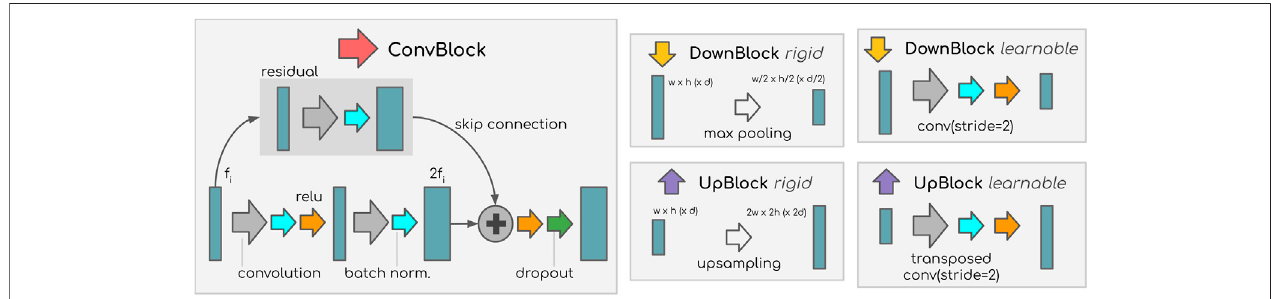
FIGURE 2 | Examples of Modular U-Net blocks. Left: our Convolutional Block. Middle/right: rigid/learnable Down-sampling Block and Up-sampling Block.